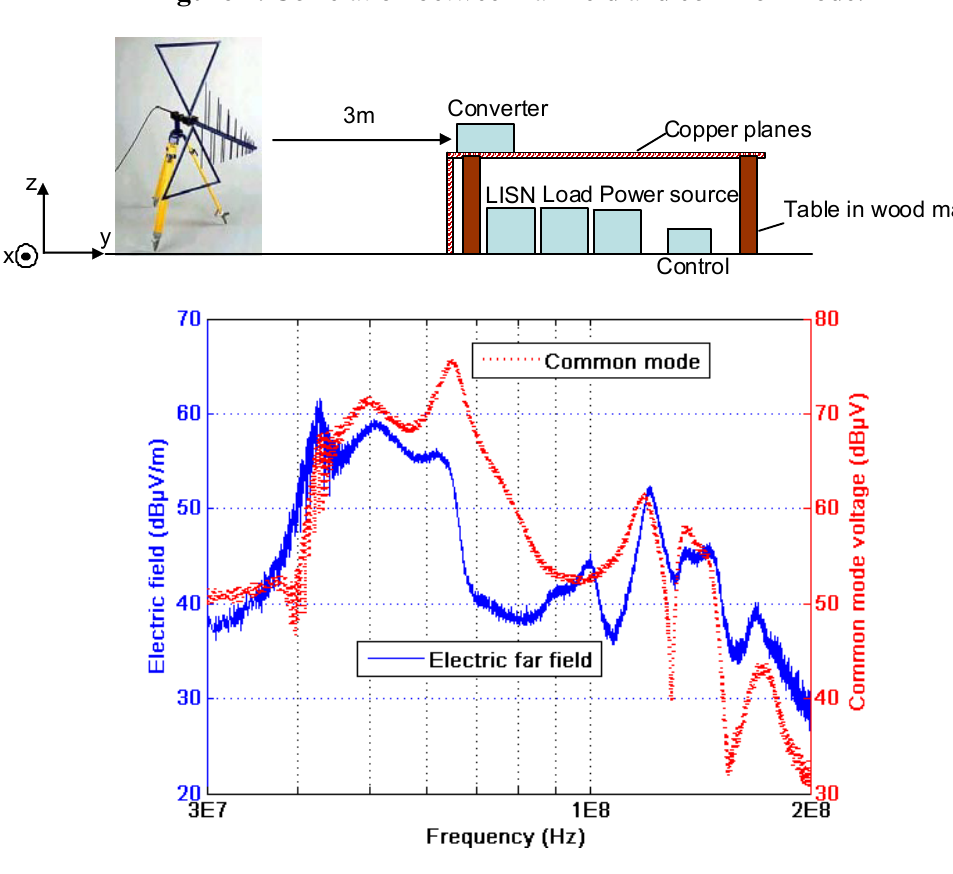
Figure 2. Correlation between far field and common